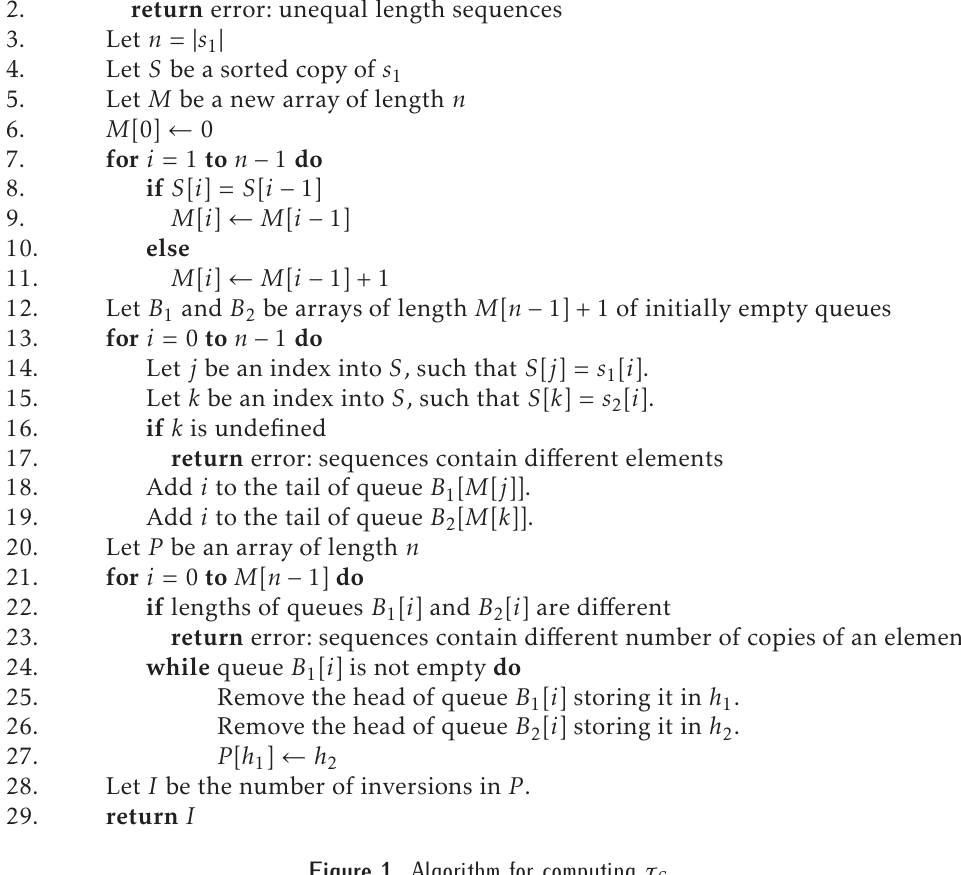
Figure 1. Algorithm for computing τ